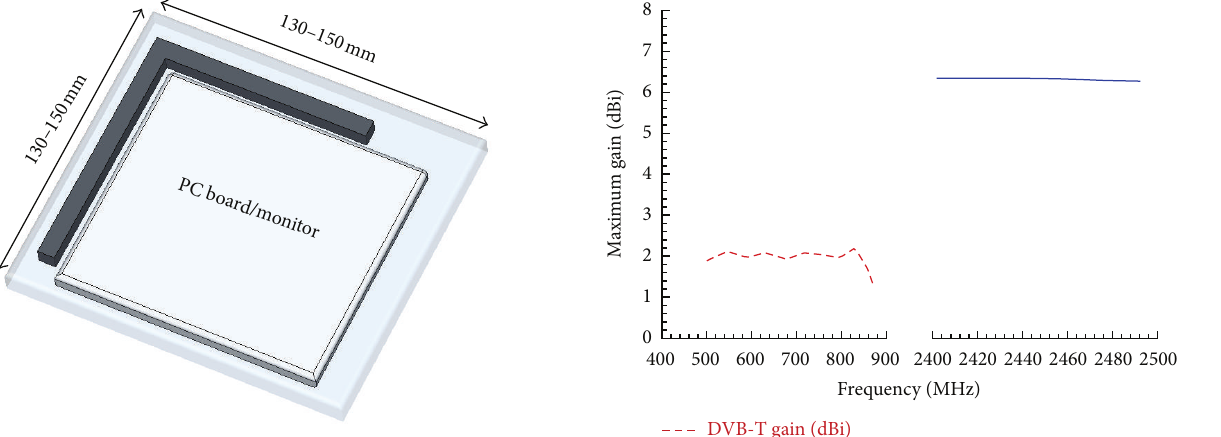
Figure 11: Example of a 3D view of a typical monitor chassis. The available space for the antenna is dark highlighted.